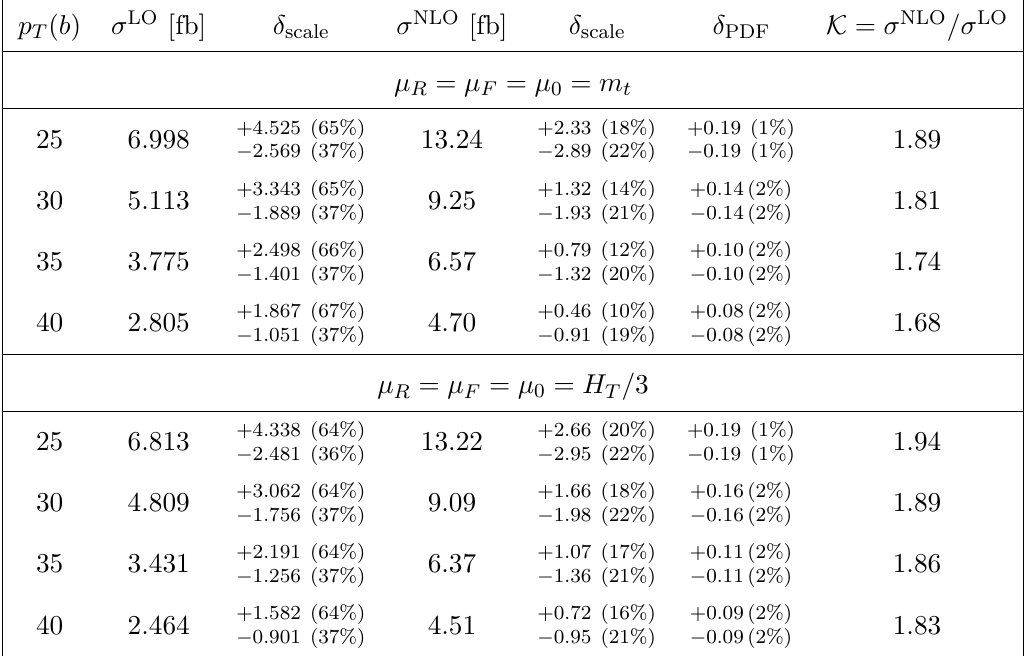
Table 3 . LO and NLO integrated fiducial cross sections for the pp → e + ν e µ − ¯ ν µ b ¯ b b ¯ b + X process √ at the LHC with s = 13 TeV. Results are evaluated using µ R = µ F = µ 0 with µ 0 = m t and µ 0 = H T / 3 . LO and NLO NNPDF3.1 PDF sets are used. We display results for four different values of the p T ( b ) cut. Also given are the theoretical uncertainties coming from scale variation ( δ scale ) and PDFs ( δ PDF ) . In the last column the K -factor is